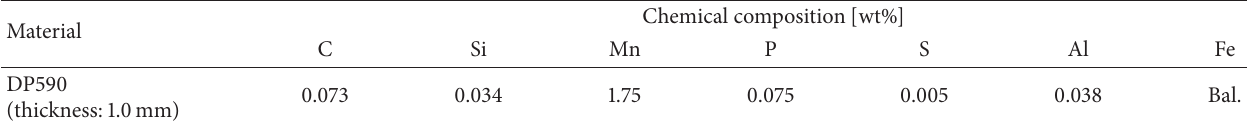
Table 1: Chemical composition of steel sheets